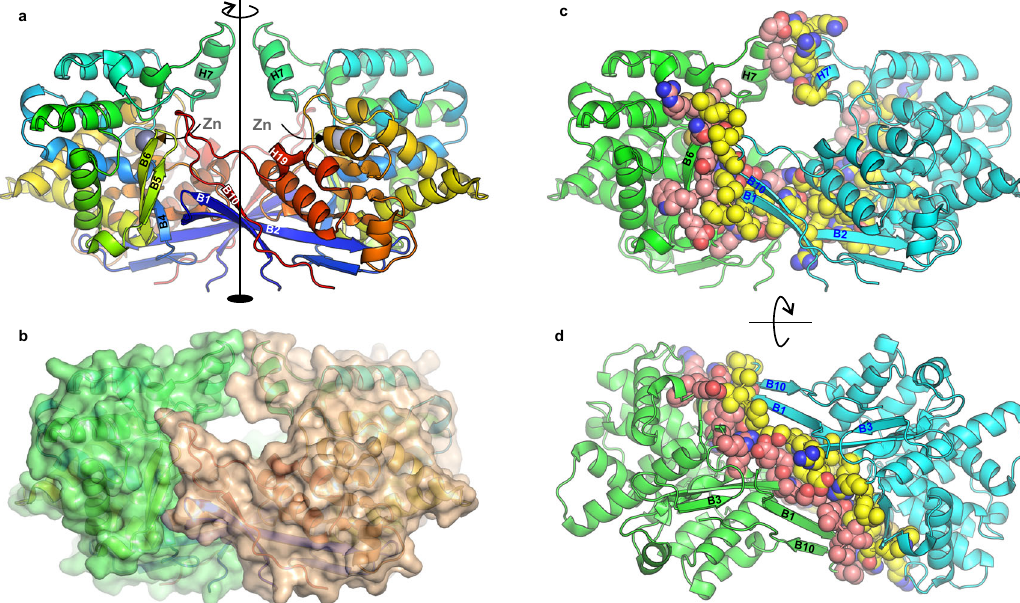
Fig. 2 The dimeric assembly of ReAV. a In the C 2 dimer, the active sites are located in the center of each subunit and contain Zn 2 + cations. b Molecular surface of the dimer, showing a tunnel of ~20 Å diameter. c Residues forming the dimer stabilization domain and helices H7 are marked as spheres. d A perpendicular view showing that the area involved in dimer stabilization extends across the dimer to include many hydrogen bonds formed between main- chain and side-chain atoms. Metal binding site . The zinc ion was found near helix H9 and the molecule w1 and Zn 2 + is in the range ~1.89 – 2.05 Å and the loop connecting strands B5 – B6, with a tetrahedral coordination position of this water is the same in all structures. The coordi- sphere formed by Cys135, Lys138, Cys189 and a water molecule nation geometry together with an X-ray fl uorescence scan and (w1) (Fig. 3a). The position of Lys138 is stabilized by two water- anomalous map, plus ITC titration results (vide infra), all mediated H-bonds to the side chain of Gln54 (Fig. 3b). These unambiguously identify the metal cation as Zn 2 + . water molecules (w7, w8) and the position of the Lys138 side chain are conserved in all analyzed ReAV structures. The position The catalytic center . Close to the Zn 2 + site, a system of four of Cys189 is nearly identical in all the structures and is addi- conspicuous residues, Ser48, Ser80, Lys51 and Lys263, is located. tionally held in place by an H-bond to the side chain of His139. In the close vicinity of the Ser48 hydroxyl, there is a characteristic, Cys135 interacts not only with the Zn ion but also with Lys51, almost tetrahedral pattern of three closely-spaced water molecules and weakly with Asn134. The two Zn-S distances are almost w2, w3, w4 (Fig. 3e), visible in all crystal structures, except MP2. identical (~2.30 – 2.31 Å). The distance between the water NATURE COMMUNICATIONS| (2021) 12:6717